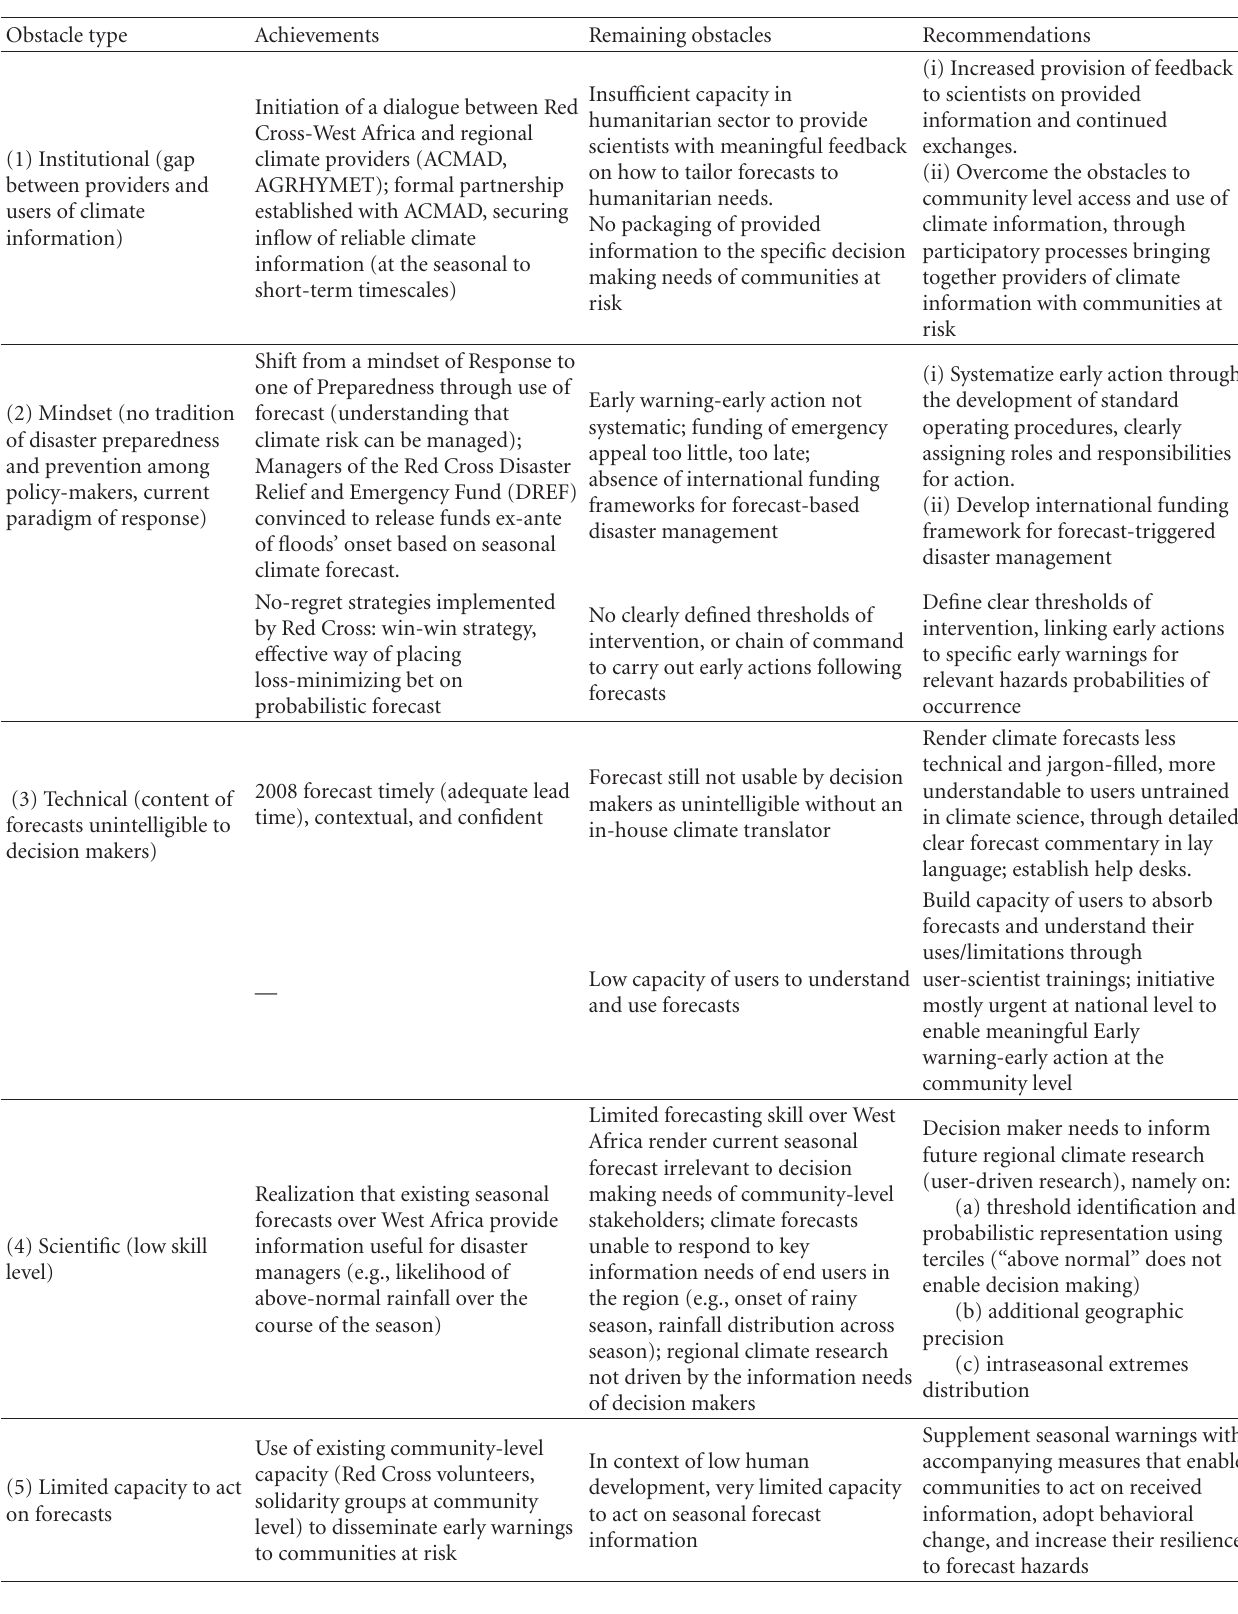
Table 1: Key Achievements, Limitations and Lessons learnt from the Red Cross’ 2008 Early Warning-Early Action initiative in West Africa. Obstacle